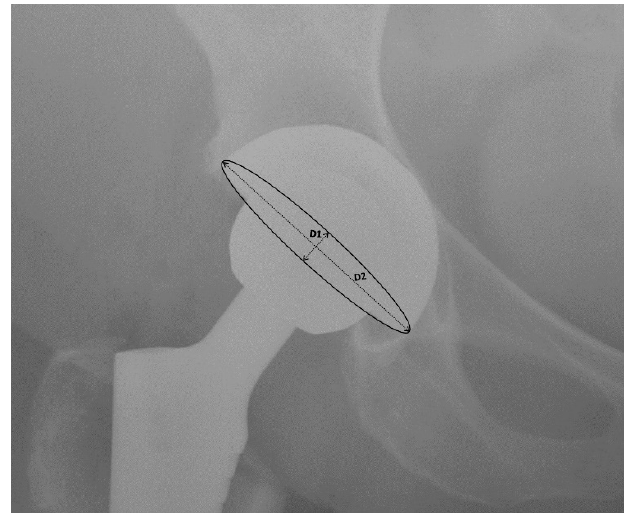
Figure 4. Cup anteversion measurement.